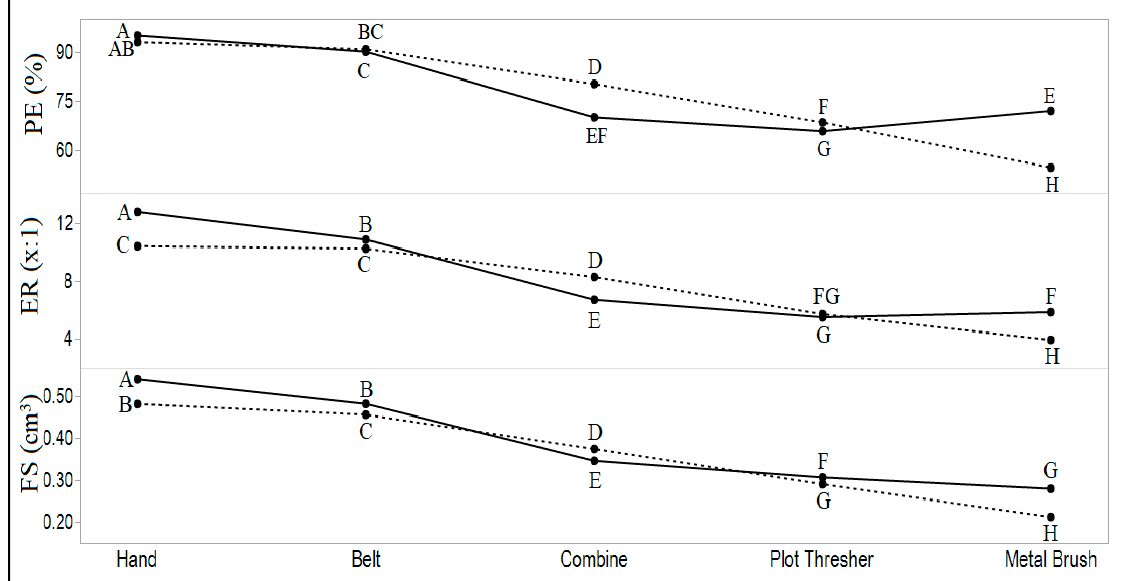
Figure 1. Least square means of popping efficacy (PE), expansion ratio (ER) and flake Size (FS) for the different combinations of threshing method and harvest moistures. The dashed line represents the low moisture harvest, and the solid line represents the high moisture harvest. Connecting letters going across for a given popping trait are not statistically different at α = 0.05 using L.S.D.